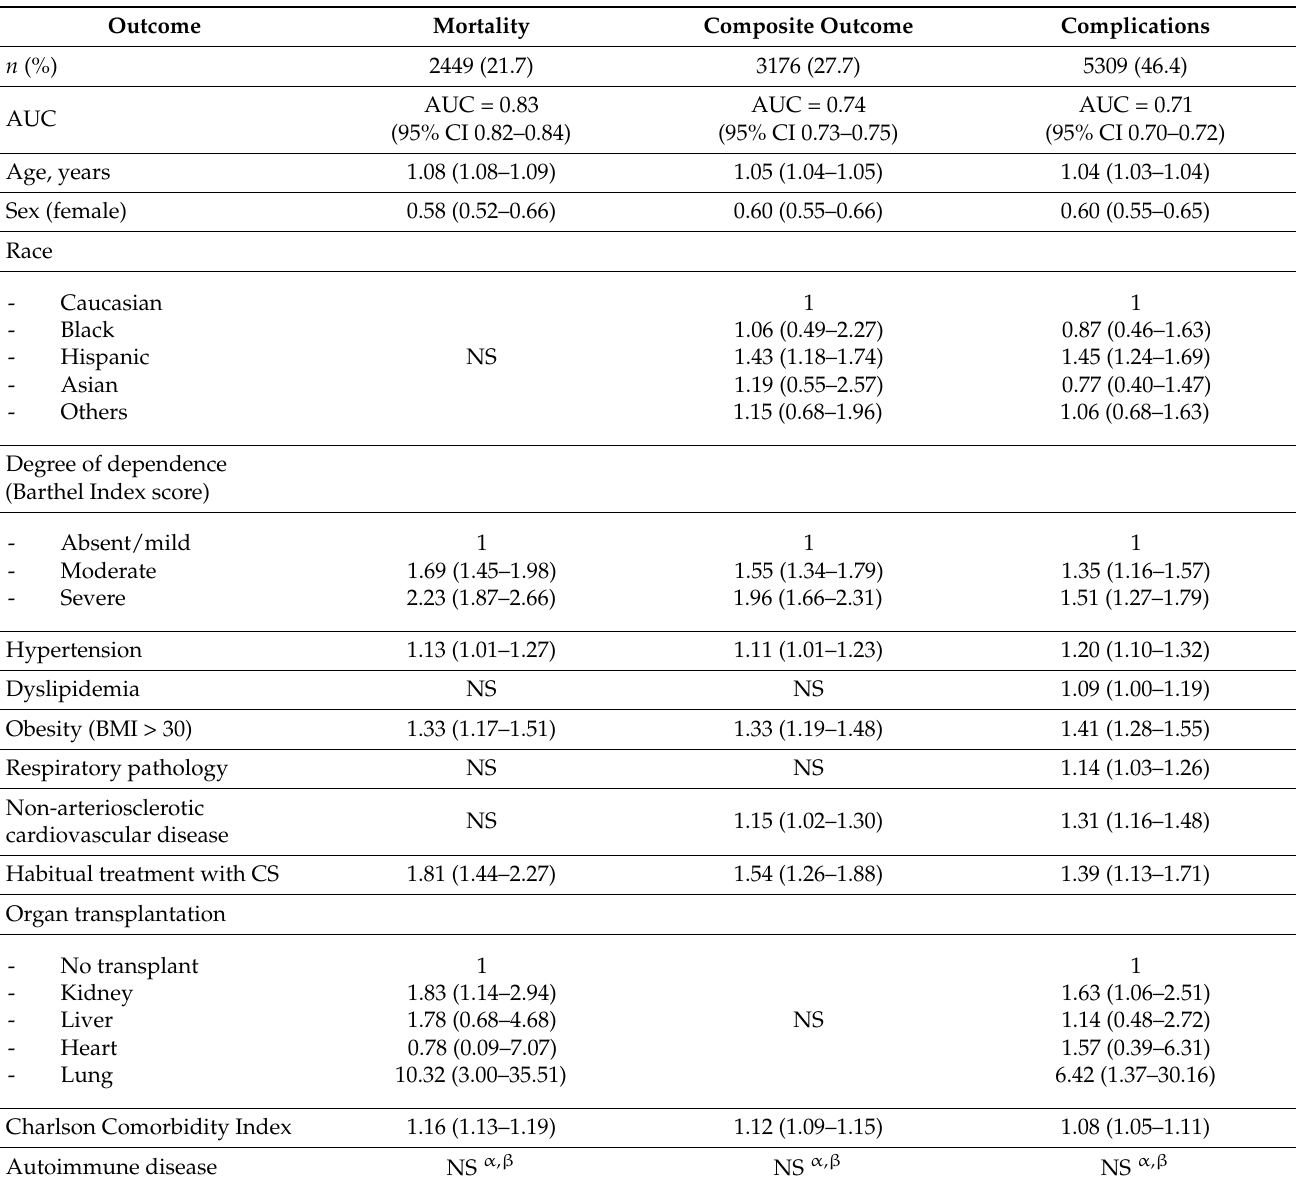
Table 5. Measures of the effect, OR (95% CI), of the ADs, sociodemographic characteristics, comorbidity, and immunomodu- latory treatments prior to admission and during hospital stay in relation to the outcome variables α